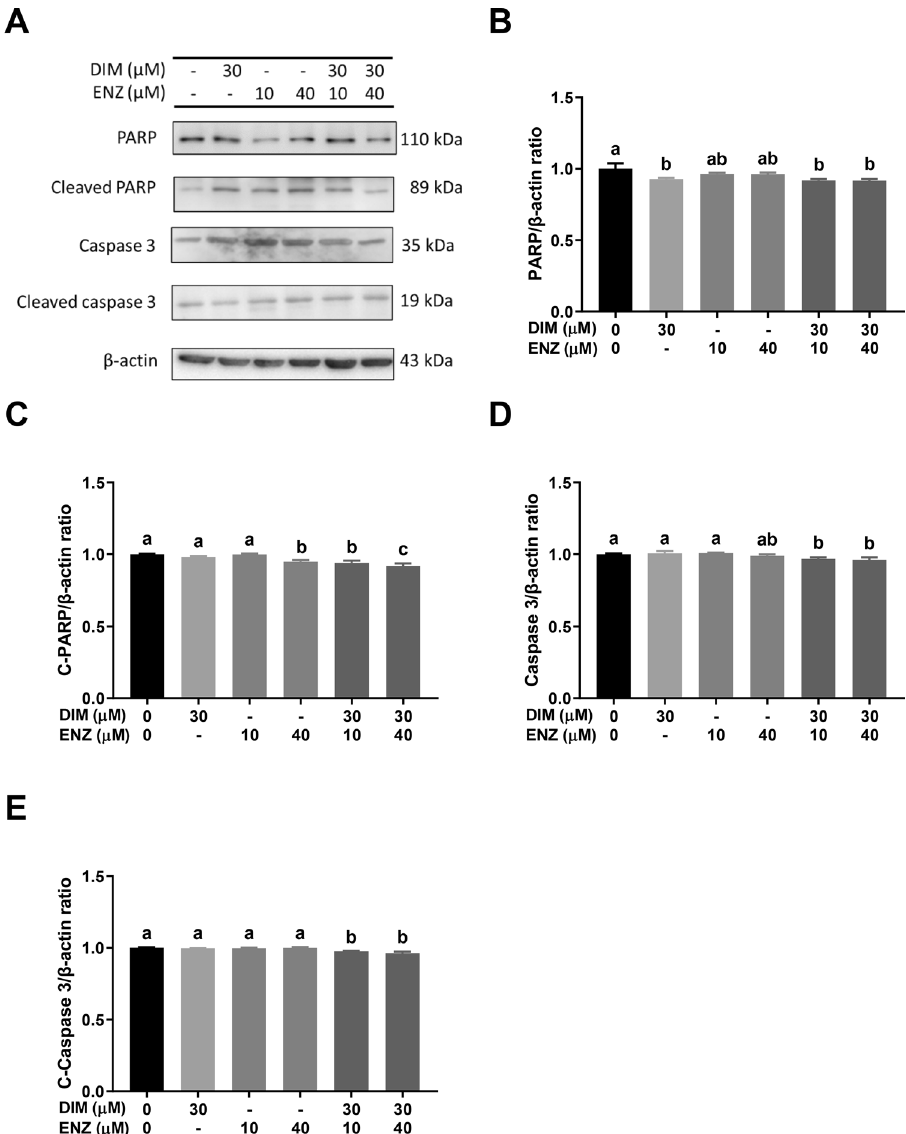
Figure 11. No evident cell cytotoxicity in 22Rv1 cells treated with DIM and ENZ for 48 h. Representative western blot image ( A ); quantitative results for PARP ( B ), C-PARP ( C ), Caspase 3 ( D ) and C-Caspase 3 ( E ). DIM 3,3 ′ -diindolylmethane; ENZ enzalutamide; PARP poly (ADP-ribose) polymerase; C-PARP cleaved poly (ADP-ribose) polymerase; C-Caspase 3 cleaved caspase 3. Values are presented as means ± SD. a,b,c Bars without the same letters at the top indicate statistically-significant differences between treatments when compared with each other (one-way ANOVA, Duncan’s new multiple range test, p <